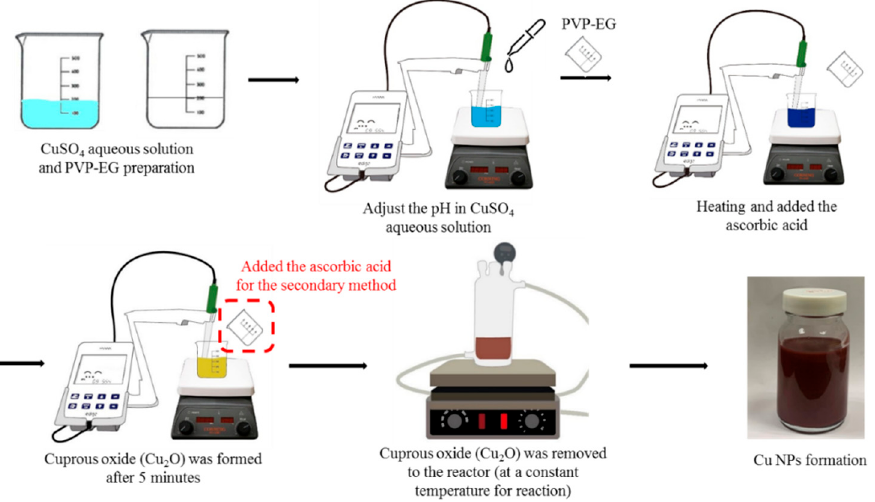
Figure 1. The preparation schematic diagram of CuNP.